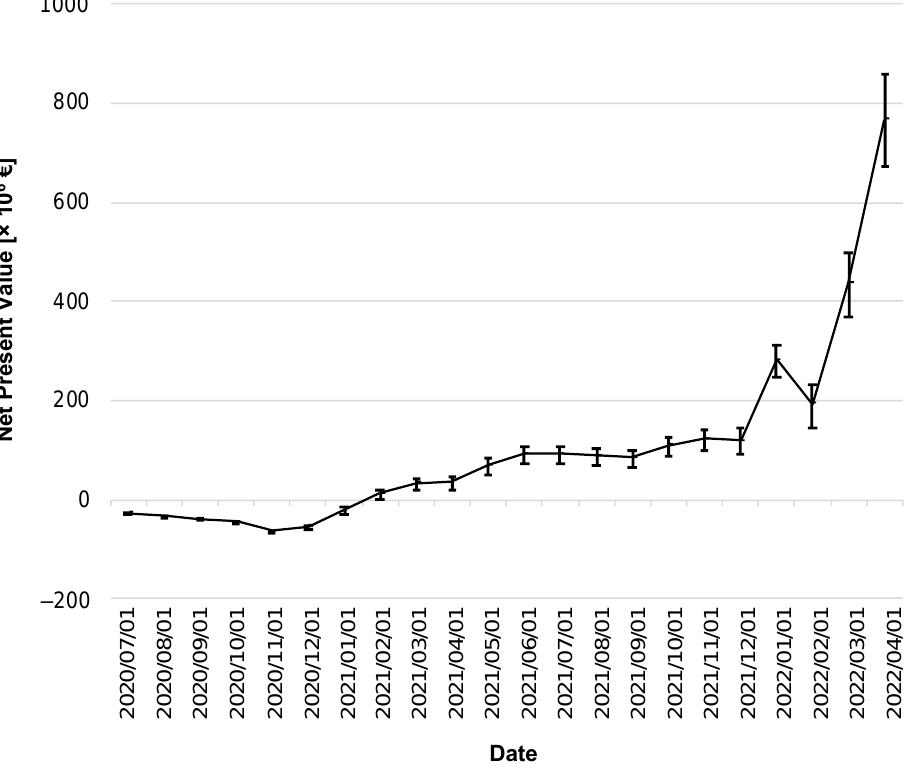
Figure 7. Net present value of the CWA over the reporting period. The discounted net present value is given in million EUR. The error bars indicate the 95% confidence interval.